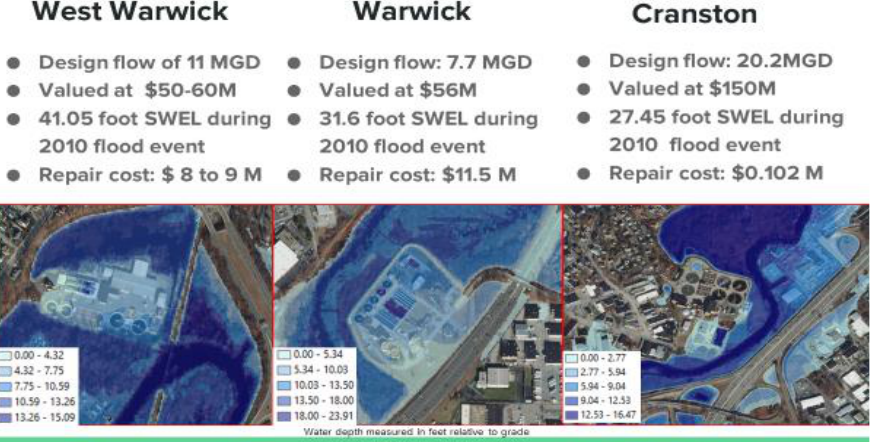
Figure 8. Map of peak flood elevation (SWEL-Still Water Elevation, in ft relative to grade elevation) of the West Warwick, Warwick, and Cranston WWTF for the March/April 2010 flood event. The upper panel shows the design flow rates, value of the facility, still water flood elevation, and estimated repair costs provided by the plant operators.